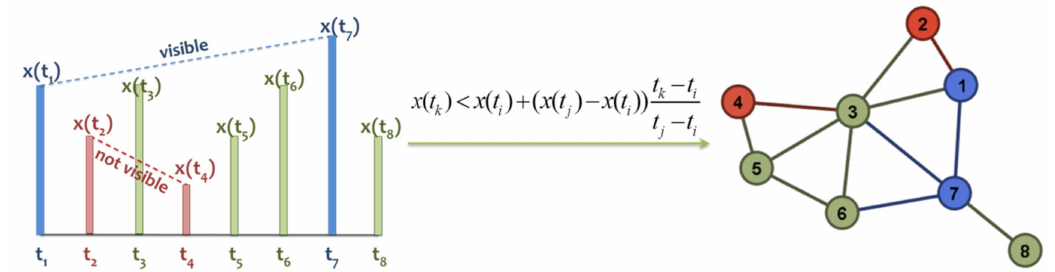
Figure 2. ( left ) Example of a pair of visible (in blue) and not visible (in red) time-series nodes according to the natural visibility algorithm (NVG); ( right ) the visibility graph associated to the time-series shown at the left